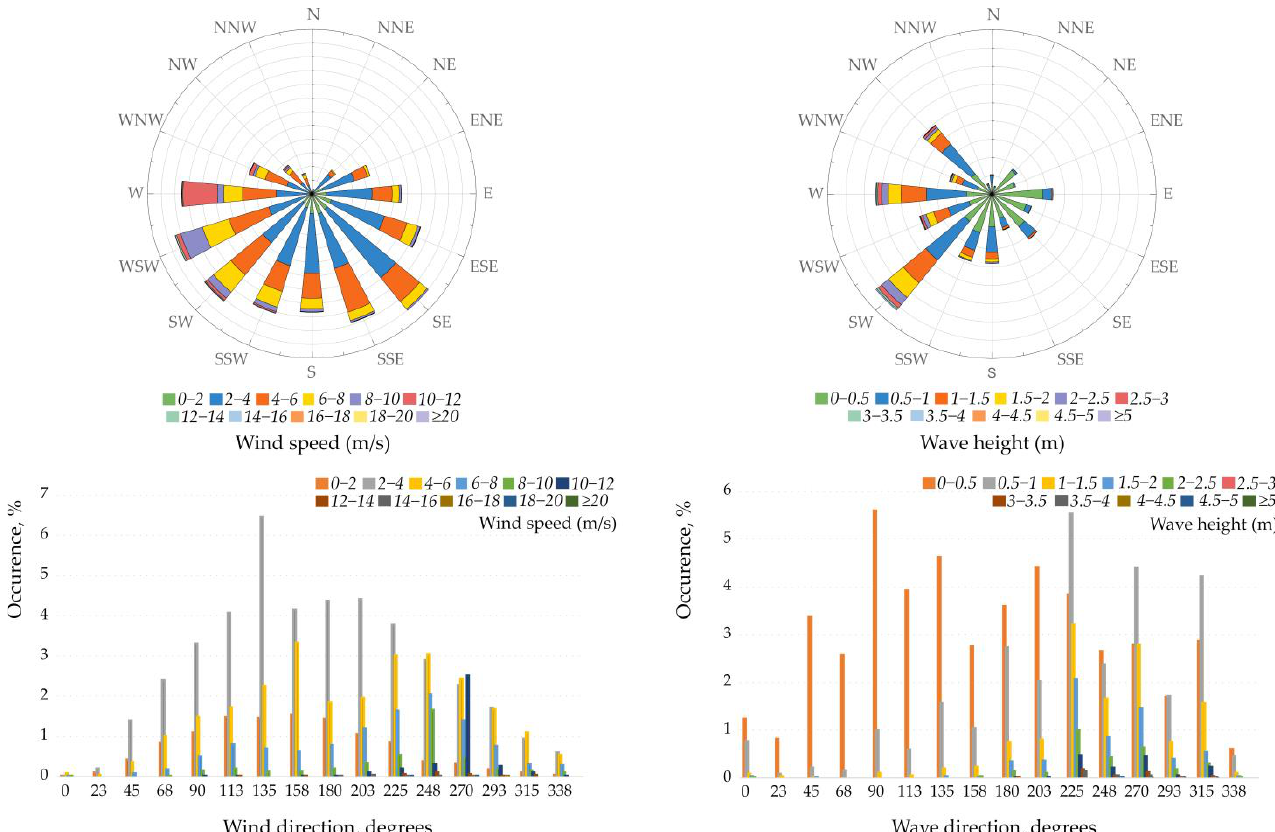
Figure 5. The wind rose diagram for wind direction, and wind speed (m/s) from 1993 to 2021, and wave rose diagram for wave direction and mean wave height (m) from 1993 to 2019, the frequency distribution of wind speed (m/s) from 1993 to 2021, and frequency distribution of wave height (m) from 1993 to 2019.